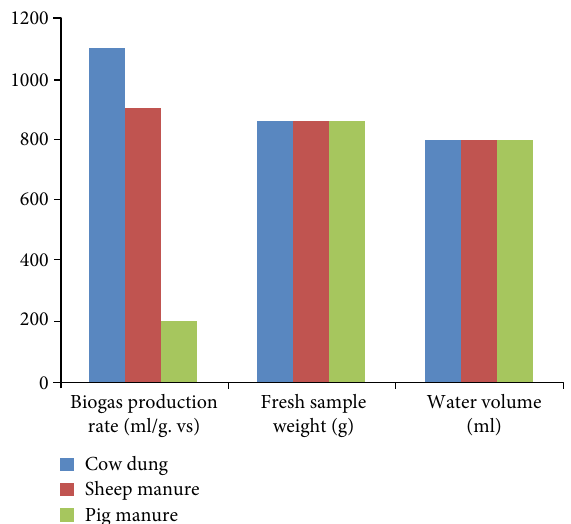
Figure 4: Biogas composition by % volume.